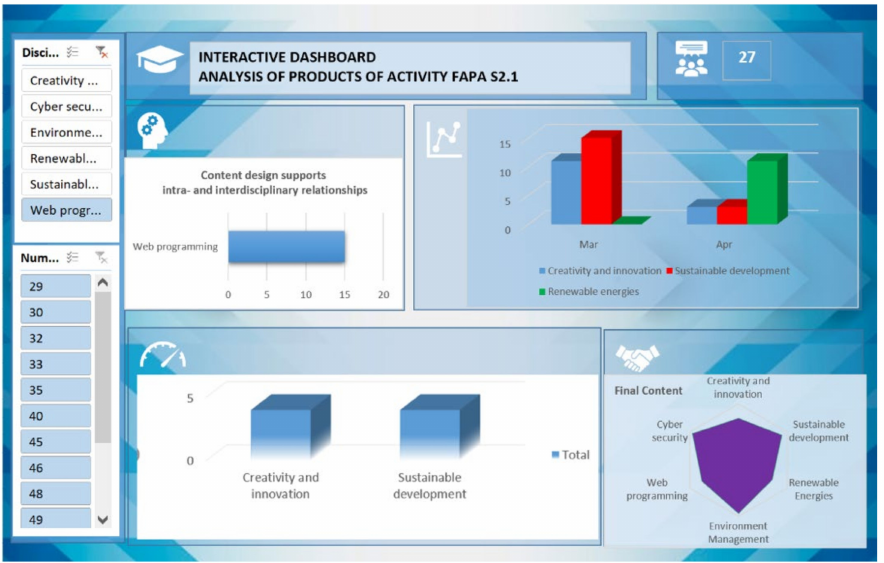
Figure 4. EvalMathI dashboard for courses panel—beta